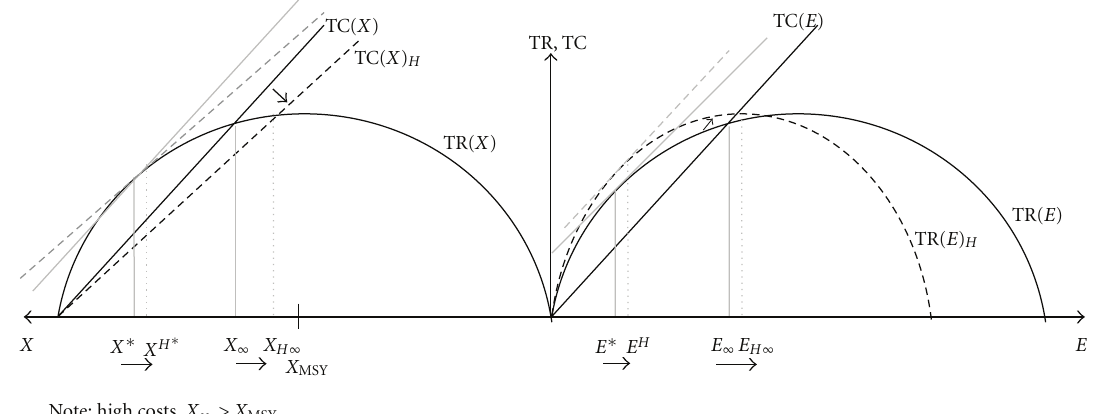
Figure 4: The e ff ect of habitat via the catchability on TR, TC, and equilibrium solutions under open access and maximum economic yield (MEY) when unit costs of e ff ort are